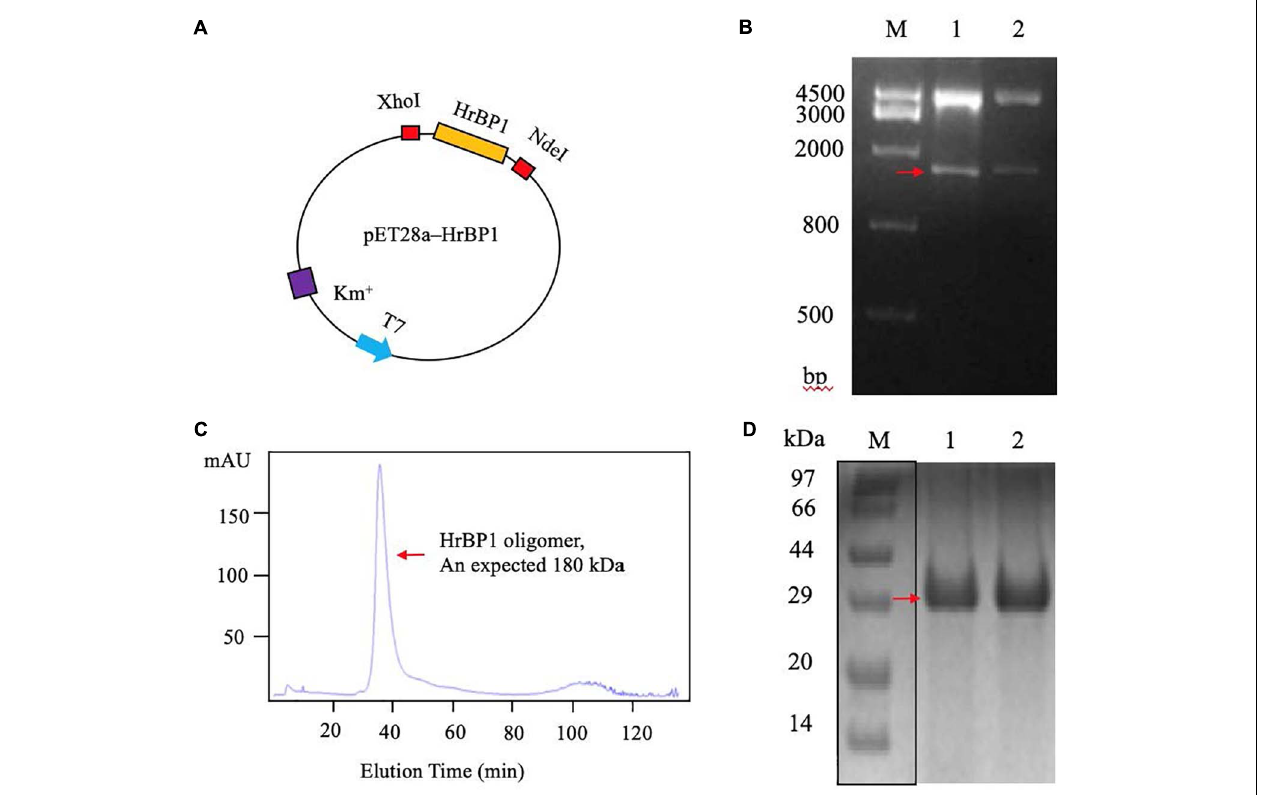
FIGURE 3 | The HrBP1 gene determination and HrBP1 protein expression and purification. (A) Recombinant vector pET28a-HrBP1 was digested by Nde I and Xho I. (B) The HrBP1 gene size (ca. 831 bp) was confirmed by 1% agarose gel electrophoresis. Lane M is a DNA marker; Lanes 1 and 2 shows the digestion of HrBP1 gene by Nde I and Xho I in the pET28a-HrBP1 recombinant plasmid; the red arrow shows bands of HrBP1 bands. (C) HrBP1 oligomer protein with expected size 180 kDa between 440 kDa (Ferritin) and 158 kDa (IgG). (D) M is protein Marker; Lanes 1 and 2 are HrBP1 purification proteins in 12% SDS-PAGE; the red arrow shows HrBP1